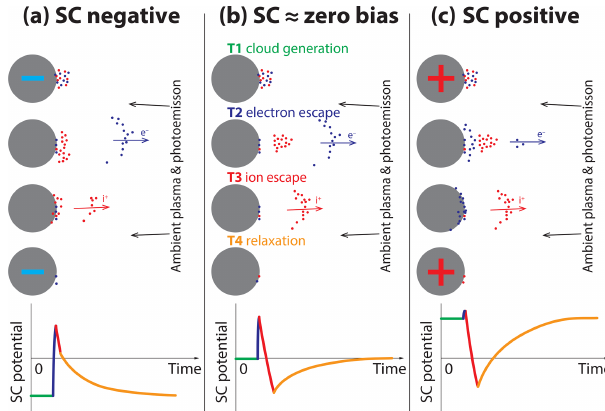
Figure 3. This figure sketches the impact process for a spacecraft that is slightly negatively charged (a) , zero biased (b) and slightly positively charged (c) . It is further described in the text and param- eters given in Table